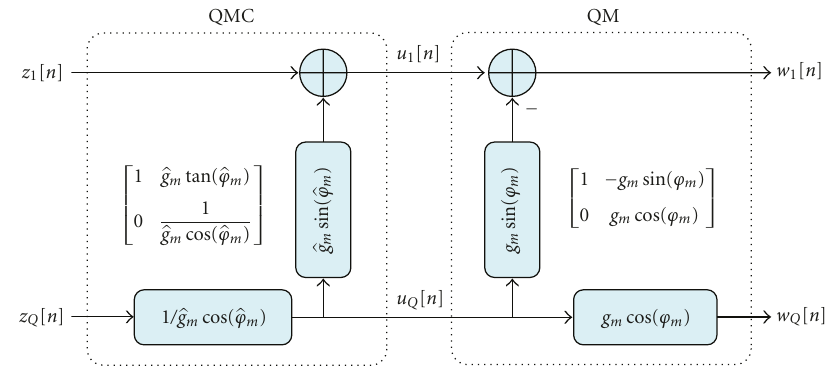
Figure 2: QM baseband model and digital predistortion structure of